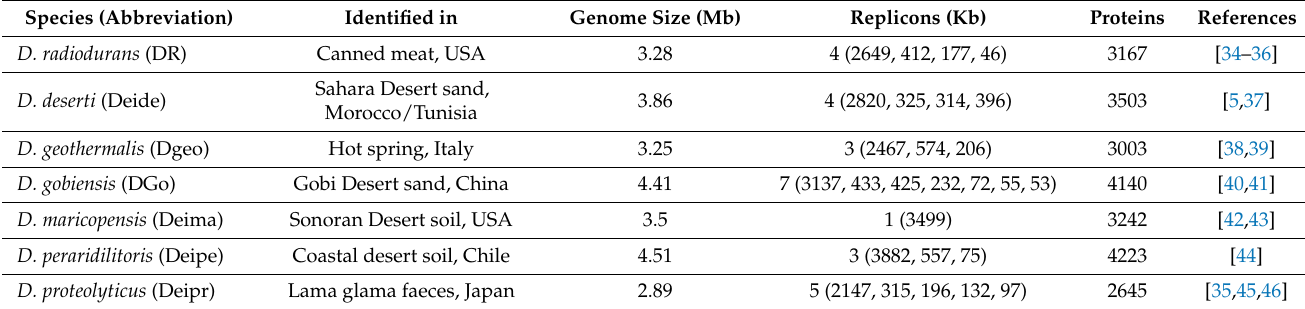
Table 1. Information of complete genomes of Deinococcus species.